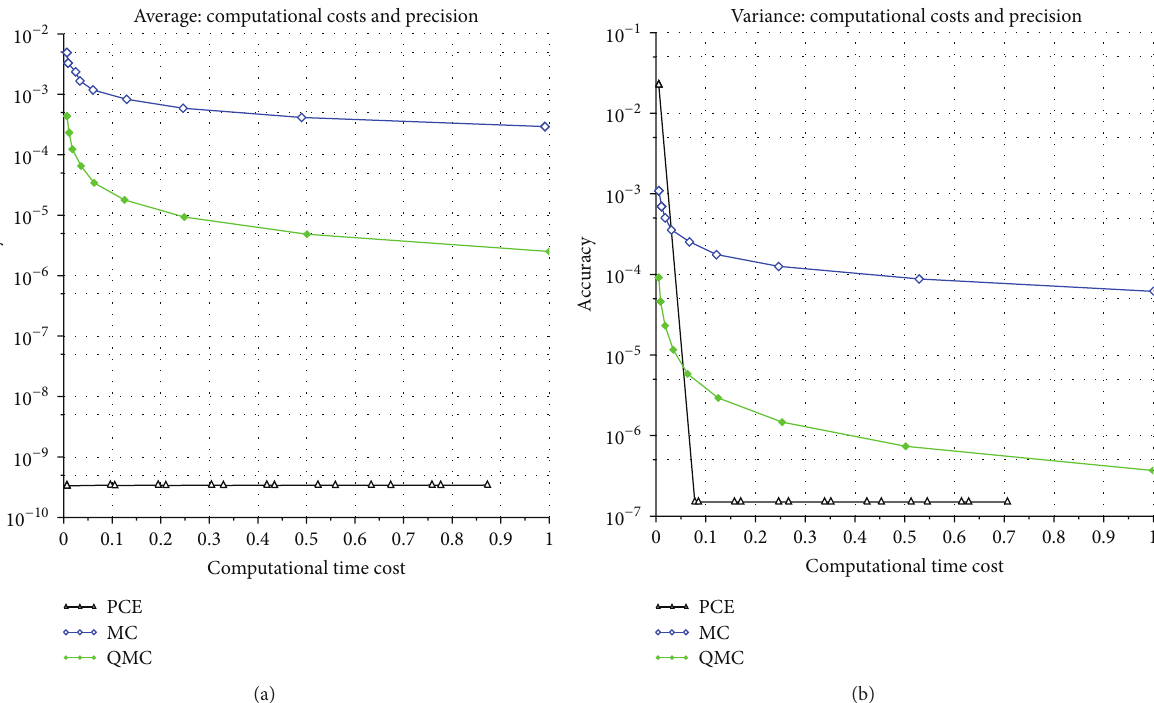
Figure 20: Semilogy scale plot of the error of mean (a) and variance (b) computed via MC, QMC, and PCE for the Vasicek model 𝑅 𝑇 at time 𝑇 = 1 , with 𝛼 = 0.1 , 𝛽 = 2 ⋅ 10 −5 , 𝜎 = 15 %, and and 𝑅 while, for the variance, we have SE 𝜎 2